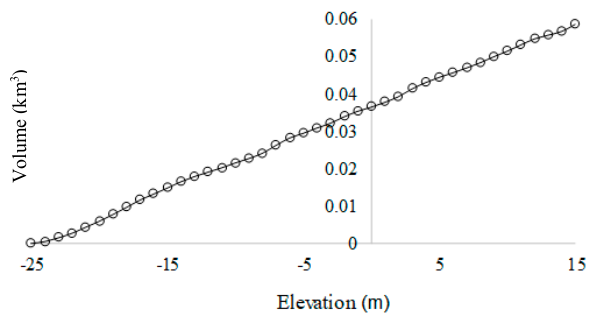
Figure 8. Cumulative storage volume curve for the Afouna Village.